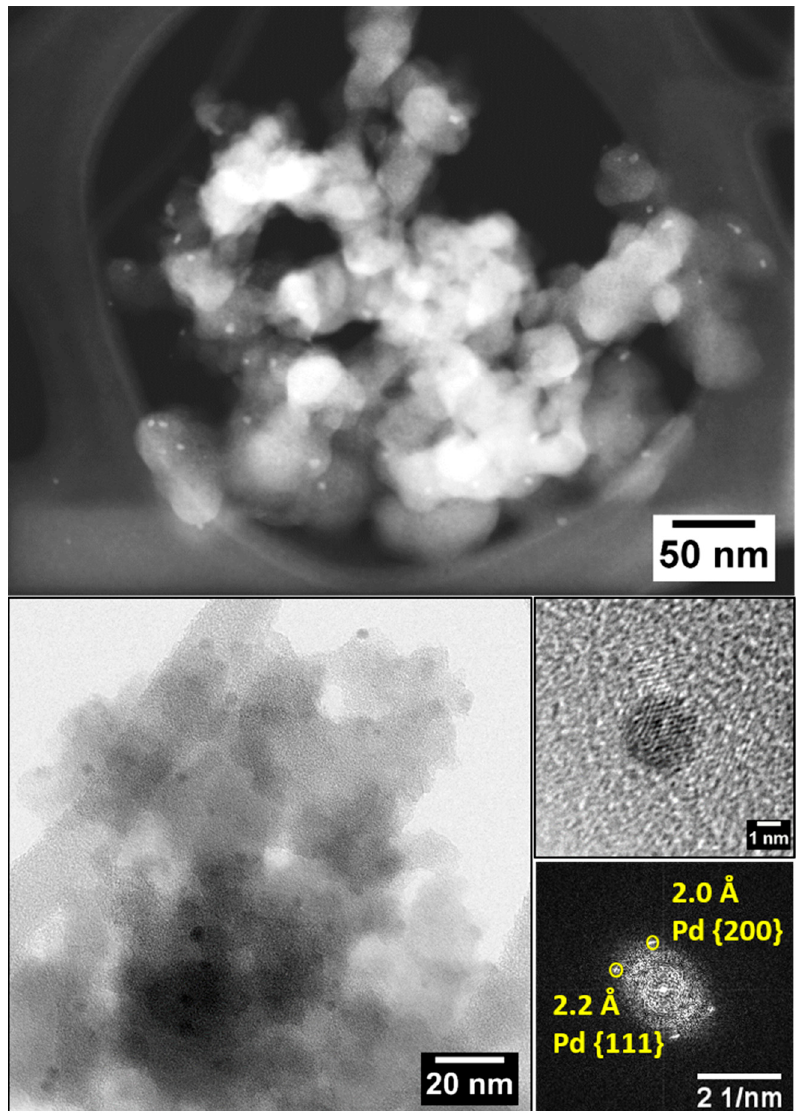
Figure 5. Representative HAADF-STEM ( top ) and TEM ( bottom, left ) microphotographs of Pd/ µ S-pDVB10 and HR-TEM of a Pd NP with corresponding FFT pattern ( bottom, right ). (cid:16) ∆ n (cid:17) (cid:16) ∆ n (cid:17) H 2 H 2 O 2 The final rate values ( , R 240 (cid:48) , R 240 (cid:48) , Table 3) were simply obtained ∆ t ∆ t s , H 2 s , H 2 O 2 240 (cid:48) 240 (cid:48)